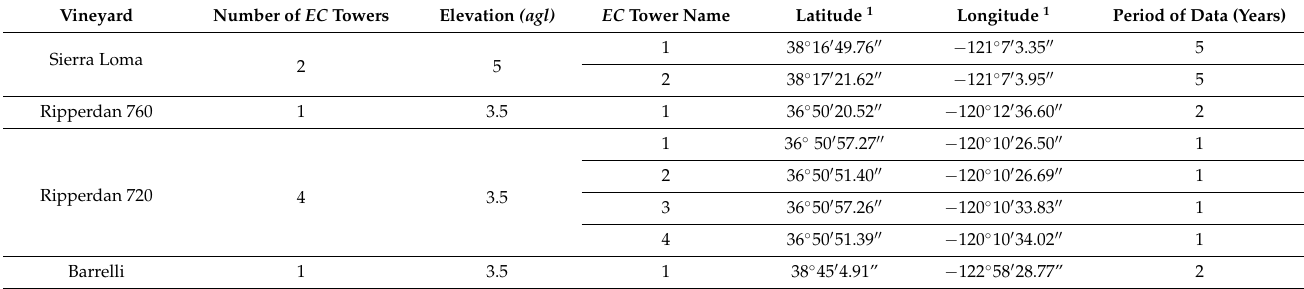
Table 2. Description of EC towers in vineyards that were part of this